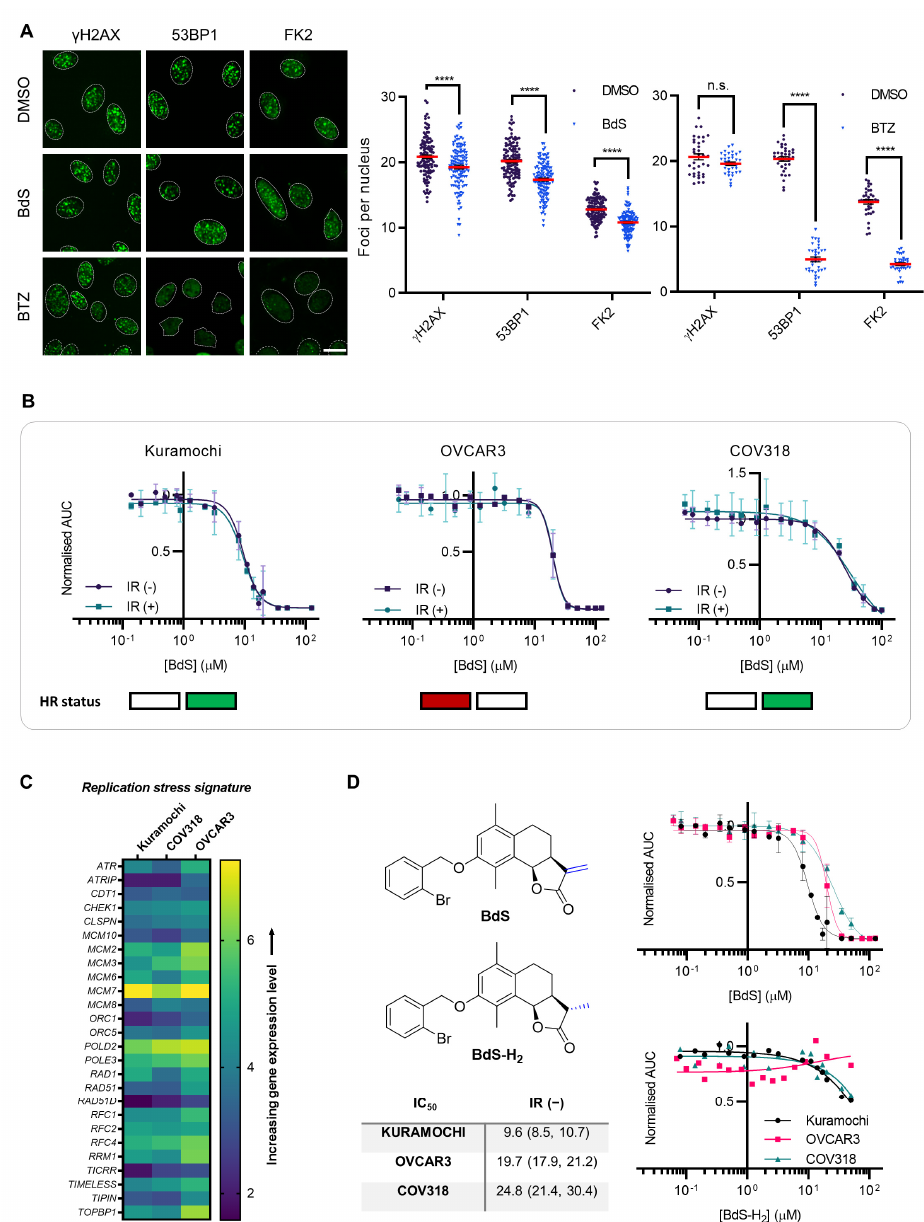
Figure 2. Effects of BdS on DNA repair and cell growth. ( A ) Left: Representative images of U2OS cells treated with BdS, BTZ, or vehicle only (DMSO). Nuclei are outlined in white using DAPI as a reference (scale bar—20 µ m). Right: Quantification of foci number per cell for DNA damage response (DDR) factors ( γ H2AX, 53BP1, FK2; Alexa Fluor 488). For BdS: each dataset represents a minimum of 3000 U2OS cells (3 replicates; n = 126). For bortezomib (BTZ): each dataset represents a minimum of 3000 U2OS cells (2 independent experiments; n = 36). Data points correspond to each recorded field (mean ± SEM). ( B ) Non-linear regression curve analyses of normalised growth curves of Kuramochi ( n = 3 independent experiments), OVCAR3 ( n = 3 independent experiments), and COV318 ( n = 2 independent experiments) cells in the presence of BdS or vehicle only (DMSO) ± irradiation (2 G γ ) across 136 h. Homologous recombination (HR) status of the cells is indicated below (red—deficient, green—proficient) [32,33]. ( C ) Heat map demonstrating differences in gene expression across the indicated cell lines from published data (CCLE) for key replication stress-related genes [34]. ( D ) Top left: comparison of chemical structures of BdS and its inactive analogue, BdS-H 2 (differing moiety in blue). Bottom left: IC 50 values calculated from non-linear regression curves shown in ( B ). Values